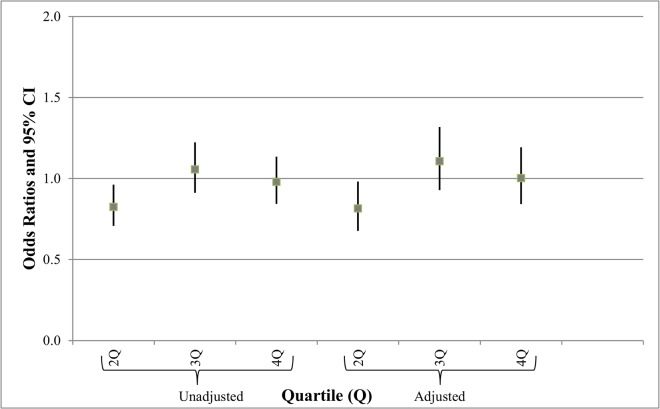
Unadjusted and adjusted odds ratios (OR) and 95% confidence intervals (CI) for prematurity (adjusted for mom’s age, mom’s education, pre-pregnancy weight, gender of infant, prenatal visits, smoking during pregnancy, gestational diabetes, WIC, race, and birth order).Key: Referent (First quartile), <0.87 wells per mile; Second quartile (2Q), 0.87 to 2.59 wells per mile; Third quartile (3Q), 2.60 to 5.99 wells per mile; Fourth quartile (4Q), ≥6.00 wells per mile.